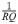
Distribution of RQ values at different glucose uptake rates (1RQ was used for the y-axis).